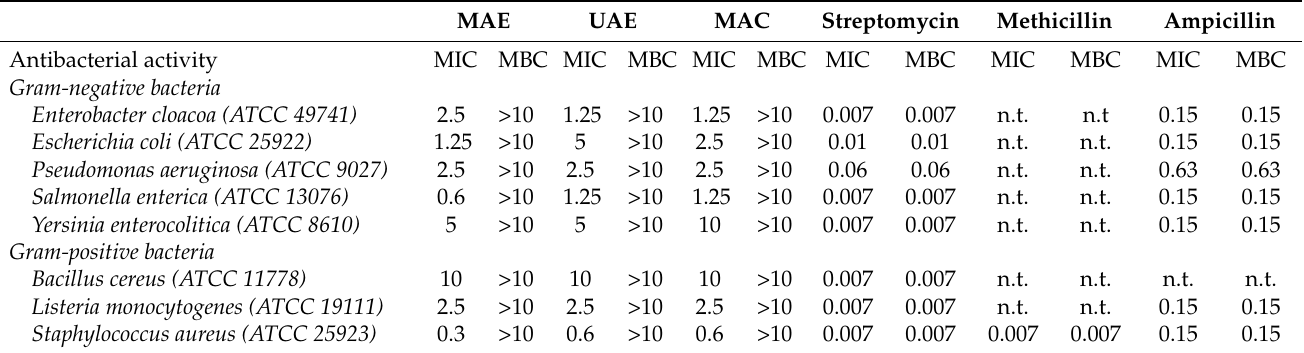
Table 7. Antibacterial activity of P. granutum leaf hydroethanolic extracts against food contaminants. MAE UAE